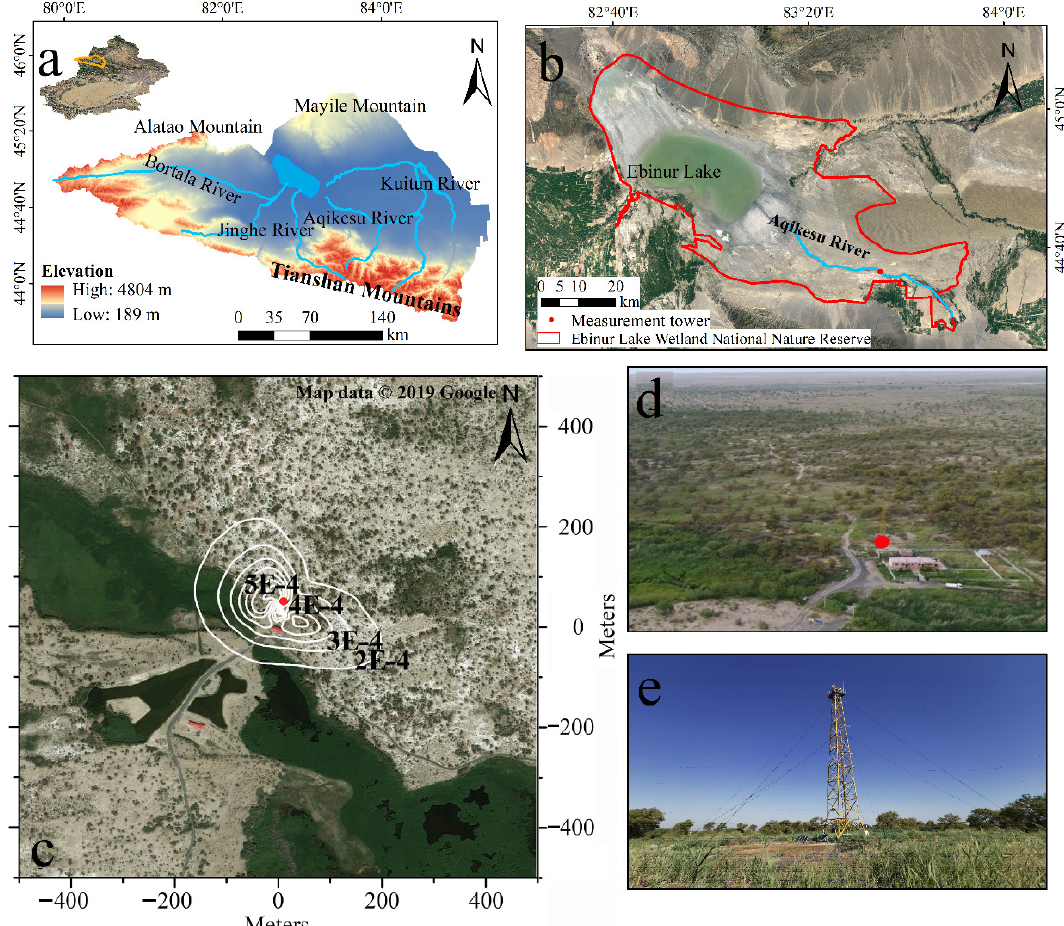
Figure 1. The measurement site in this study. ( a ) Location map of the Ebinur Lake basin; ( b ) location of the measurement tower within the region; ( c ) remote sensing image in June, with the average footprint for the entire observation period overlaid [34]; ( d ) aerial photo of the tower site in May; and ( e ) photograph of the tower site in August [35]. The measurement tower is marked with a red circle. White lines represent isopleths of average flux contributions to the measured